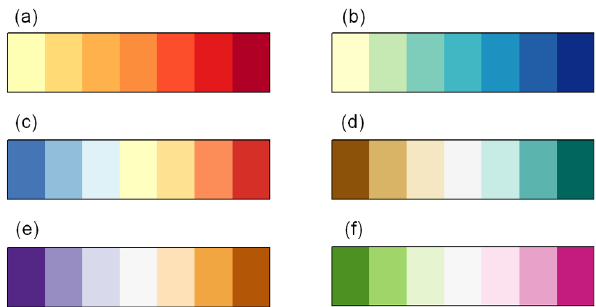
Fig. 4. Appropriate diverging and sequential colour schemes for the following climate data (a) , absolute temperature (b) , absolute precipitation (c) , temperature anomaly (d) , precipitation or runoff anomaly ( e and f ) other climate variables with no symbolic associ- ation. Schemes in this figure are 7 class ones designed by Cynthia Brewer, (Brewer et al.,